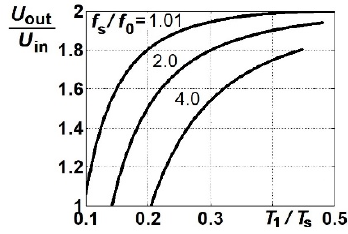
Figure 5. Normalized output voltage U out / U in of the converter as a function of T 1n = T 1 / T S for three values of f S n = f S / f 0 : 1.01, 2.0, and 4.0. P in-n = P in /( U in2 / ρ ) = 0.0344. Switching pattern P3.